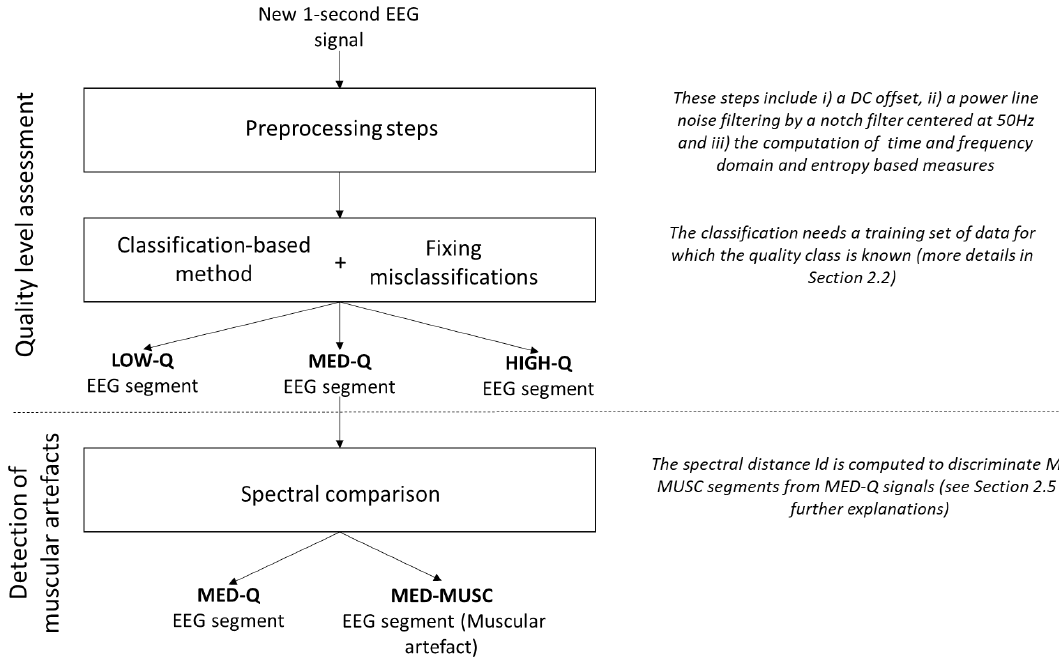
Figure 1. Overview of the contamination level assessment for a single-channel